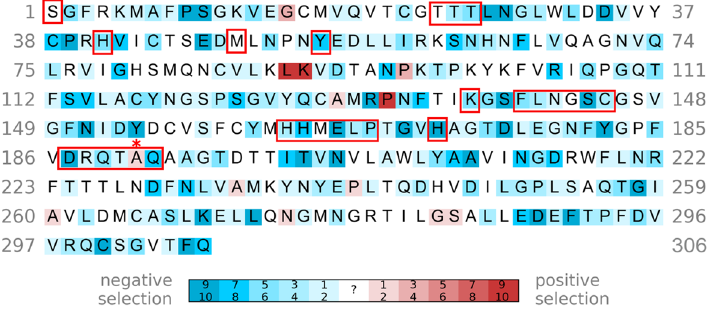
Figure 2. Selection pressure of SARS-CoV-2 M pro residues. Out of 10 sampling rounds, the number of times a residue was found to exhibit evidence (p < 0.1) for negative and positive selection is indicated by increasing blue or red intensity, whereas a residue with no evidence to support negative or positive selection is in white. All drug-interacting residues are boxed and those under positive selection are indicated by